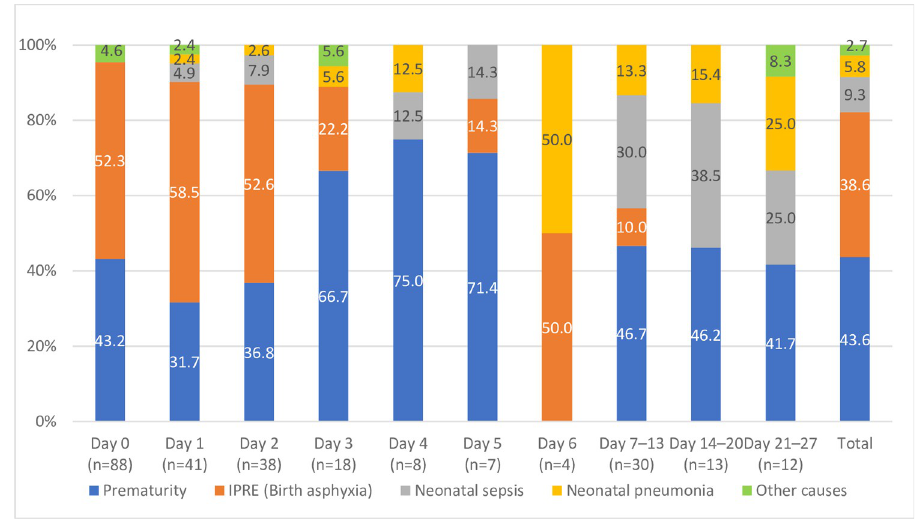
Fig 1. Cause of death by postnatal age.